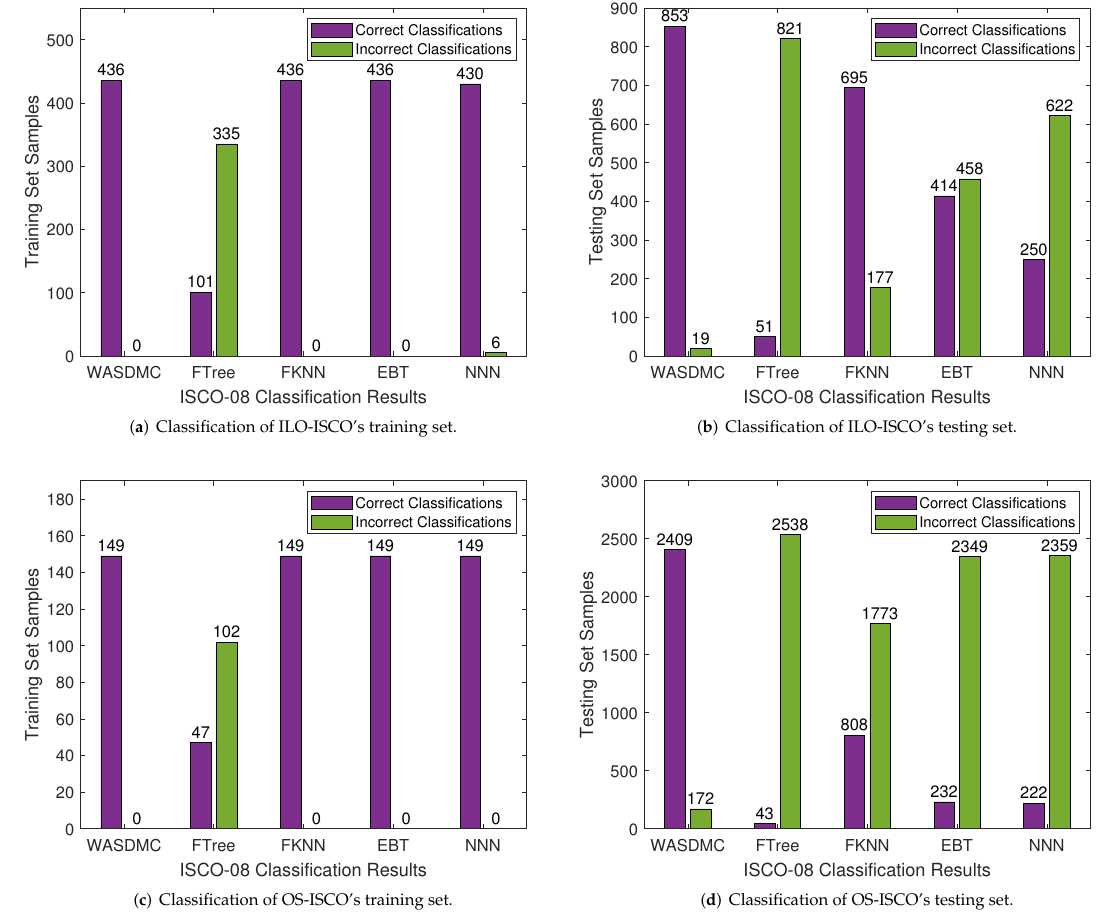
( c ) Classification of OS-ISCO’s training set. Figure 3. The classification of the ILO-ISCO’s and OS-ISCO’s training and testing sets by neural